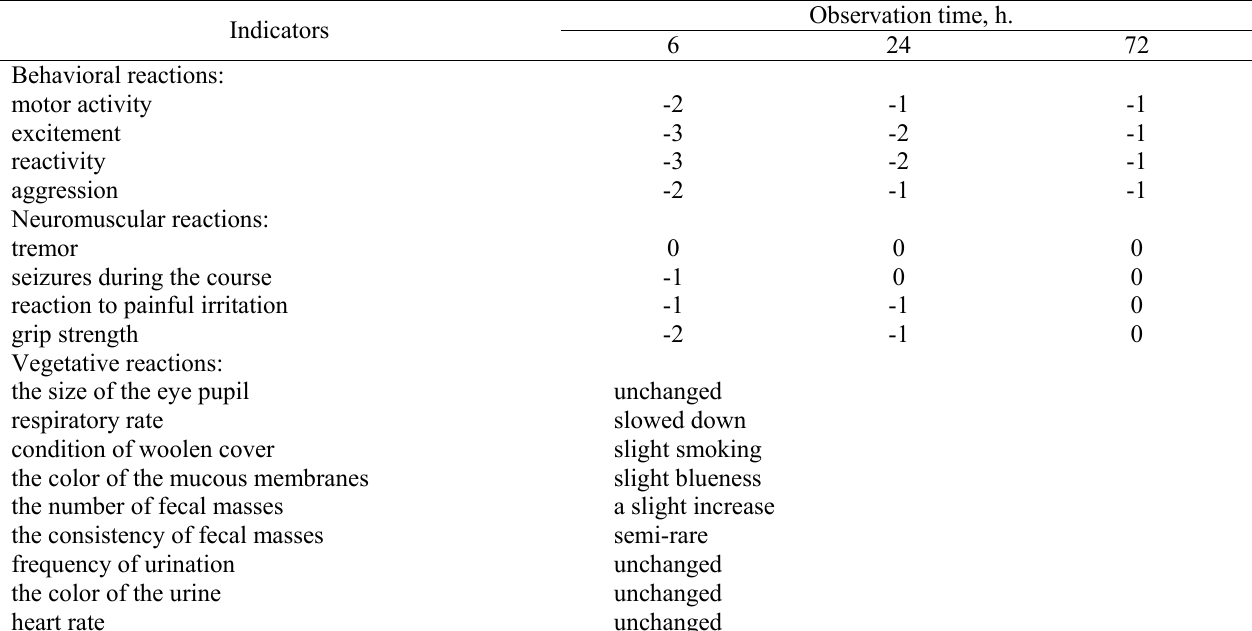
Effect of subtoxic dose of disinfectant “Zoodizin” at oral administration on the general functional parameters of experimental rats